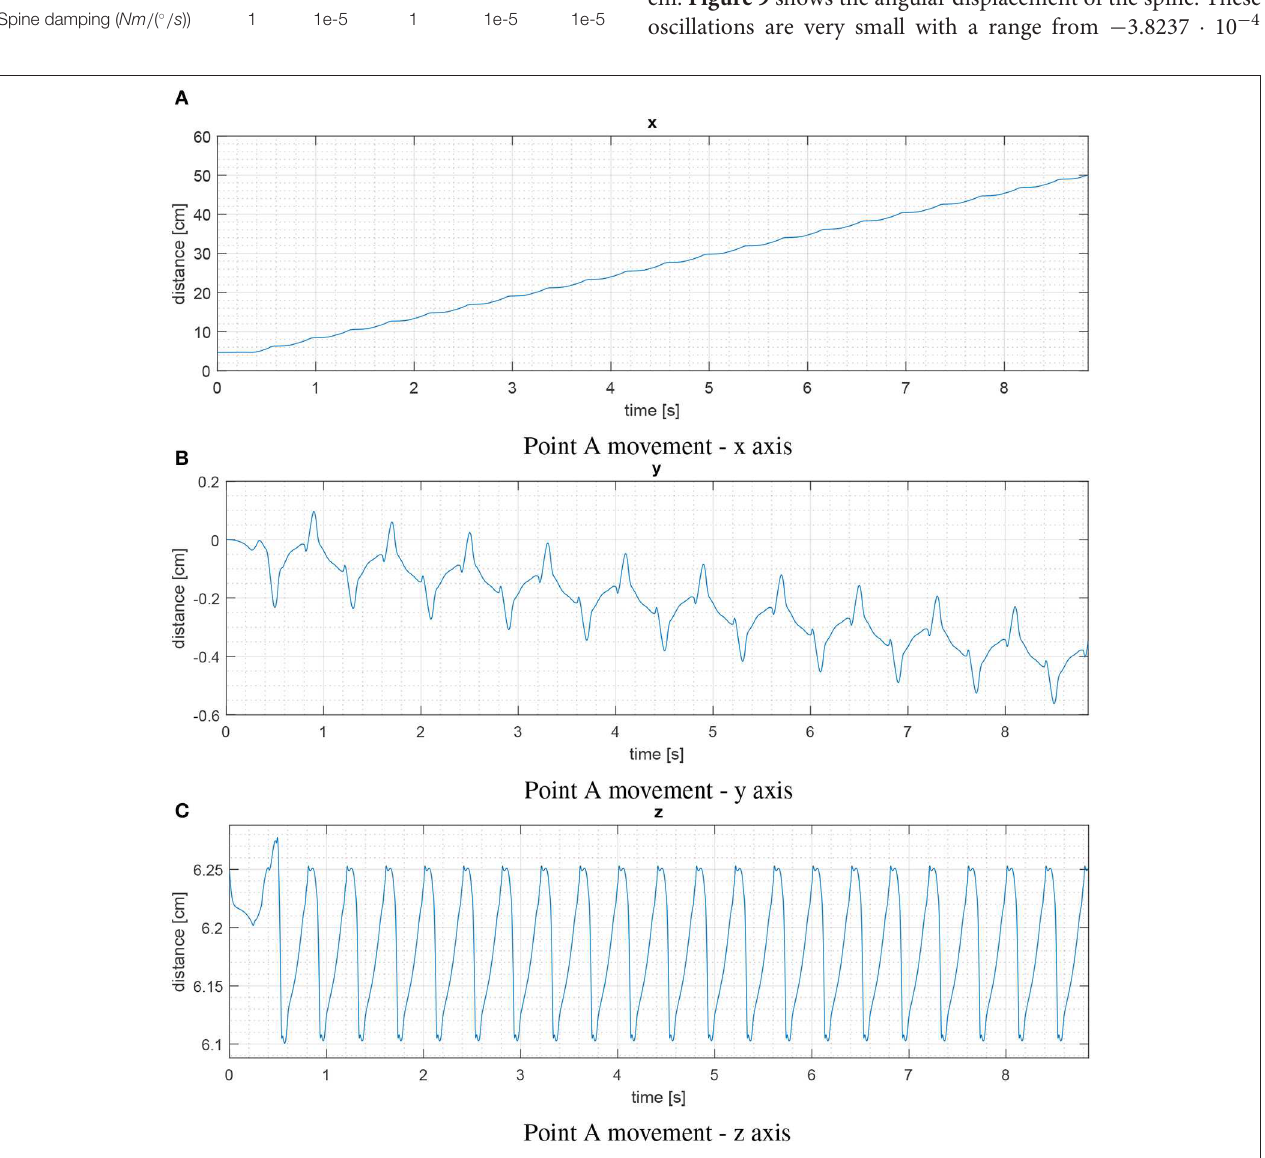
FIGURE 8 | Evolution of point A during gait in TEST